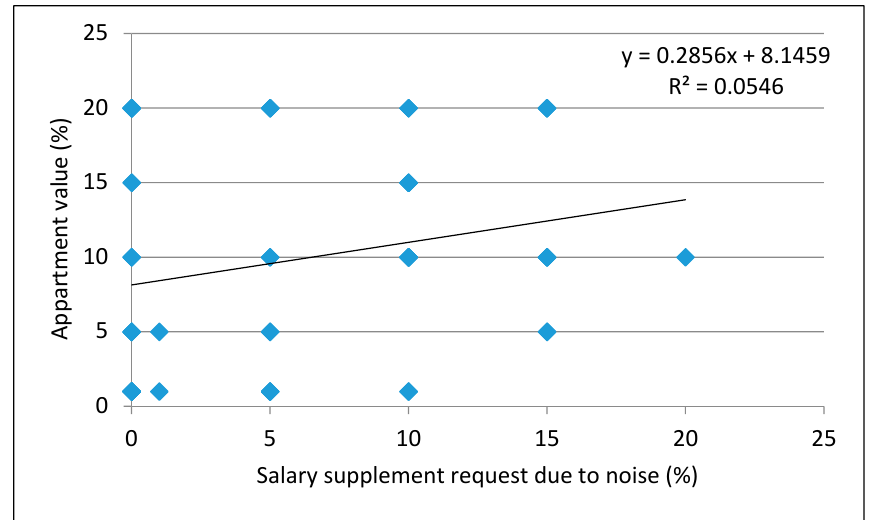
Figure 5. Dependence of attitudes about the noise influence on own apartment value on the amount of request for salary supplement due to noise.